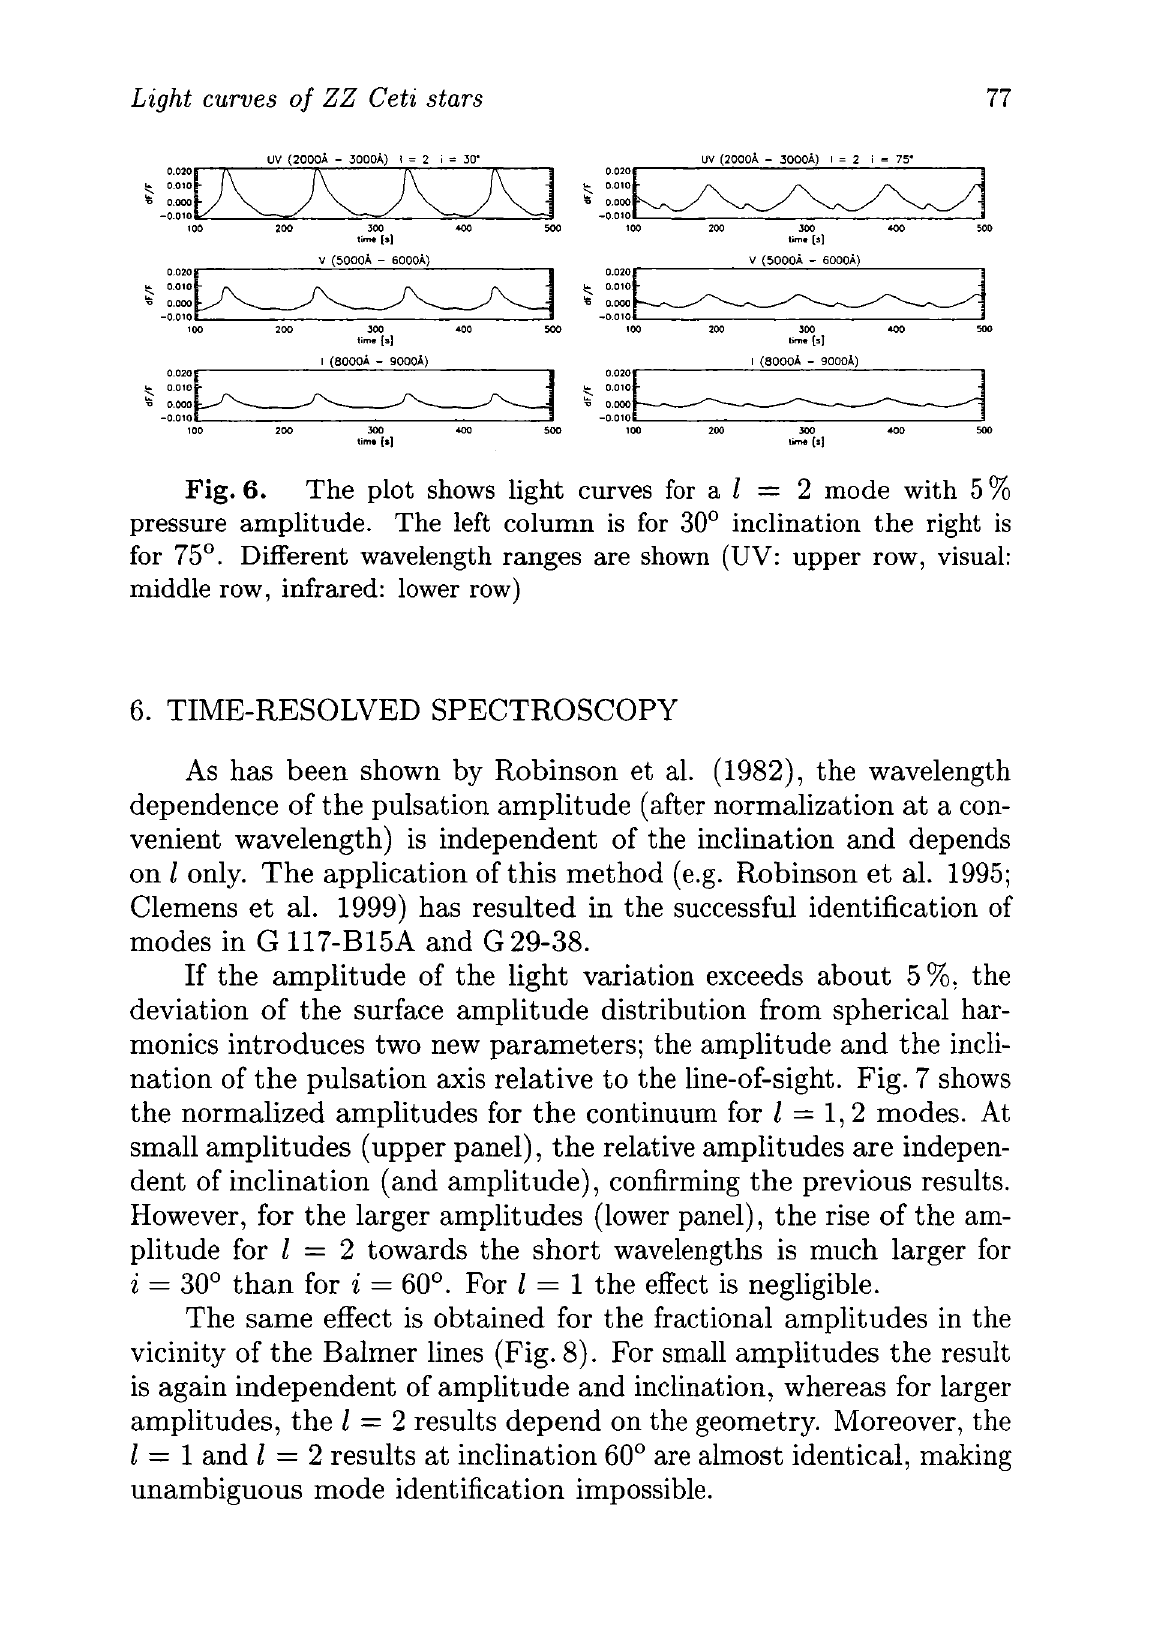
Fig. 6. The plot shows light curves for a I — 2 mode with 5 % pressure amplitude. The left column is for 30° inclination the right is for 75°. Different wavelength ranges are shown (UV: upper row, visual: middle row, infrared: lower